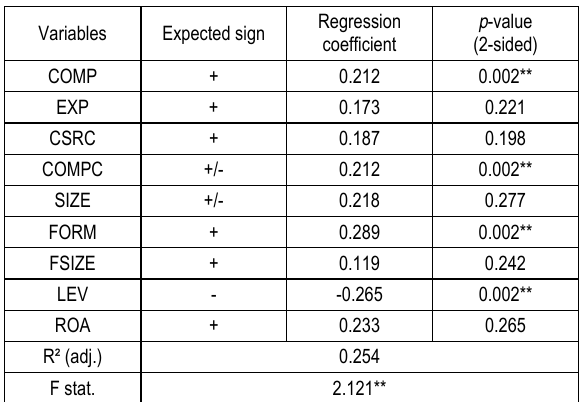
Table 6. Sensitivity